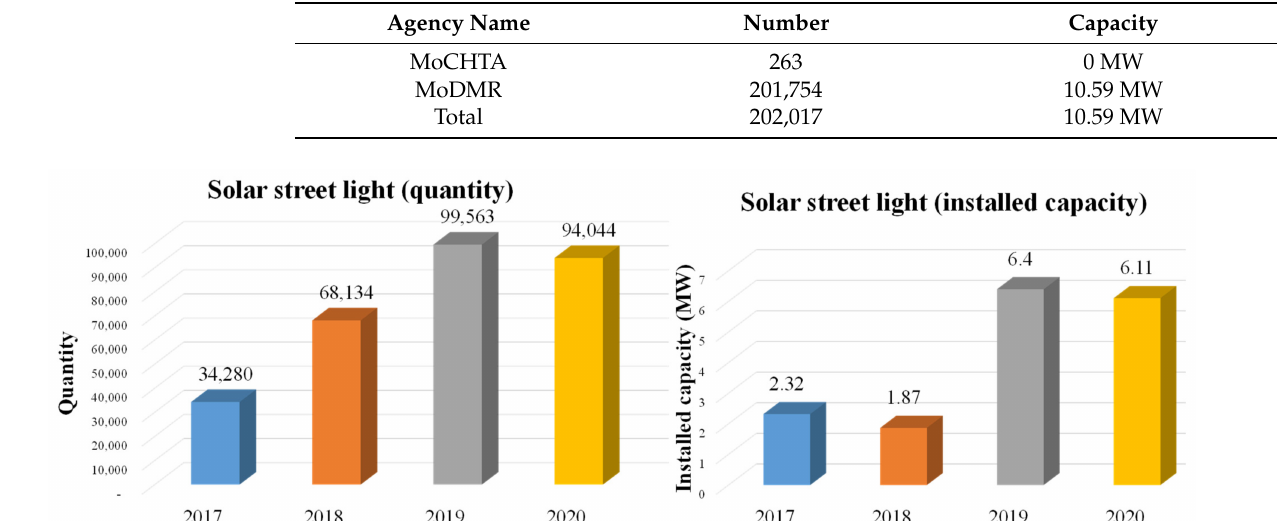
Figure 21. The historical installed quantity and installed capacity of solar street lights (2017–2020) (authors’ creation based on SREDA data [21]).